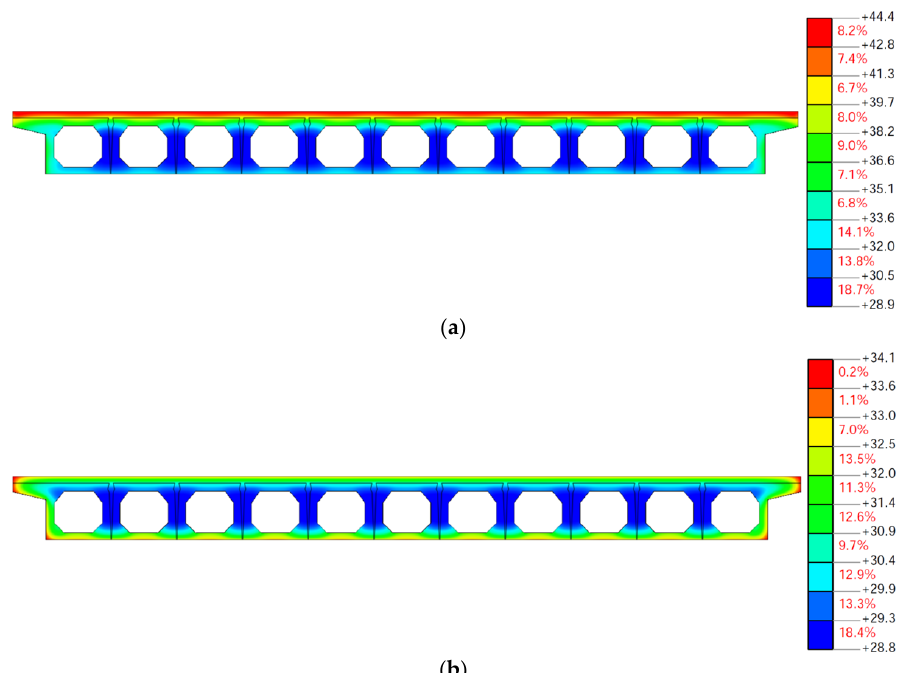
Figure 18. Temperature contour plots of side-by-side box girder at 16:00 on 31 July 2014: ( a ) with solar radiation; and ( b ) without solar radiation. radiation; and ( b ) without solar